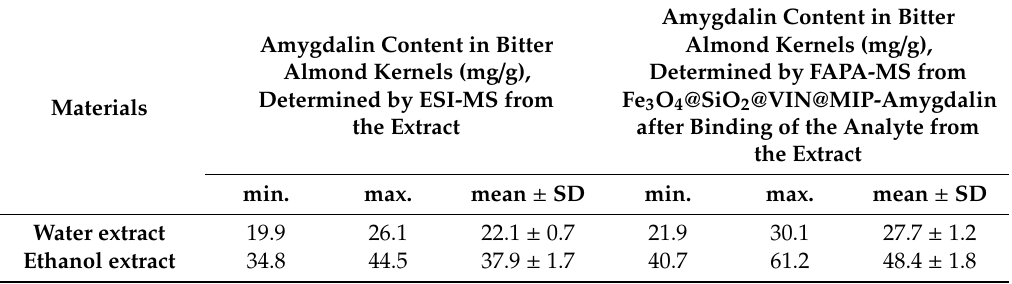
Table 7. The content of amygdalin in bitter almond kernels.